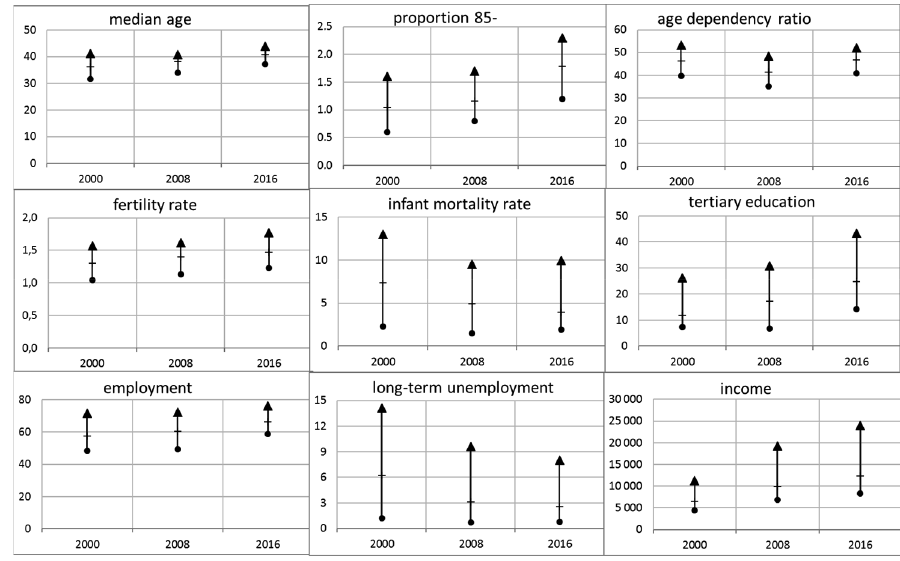
Figure 5. Development of absolute differences in the indicators examined (%)